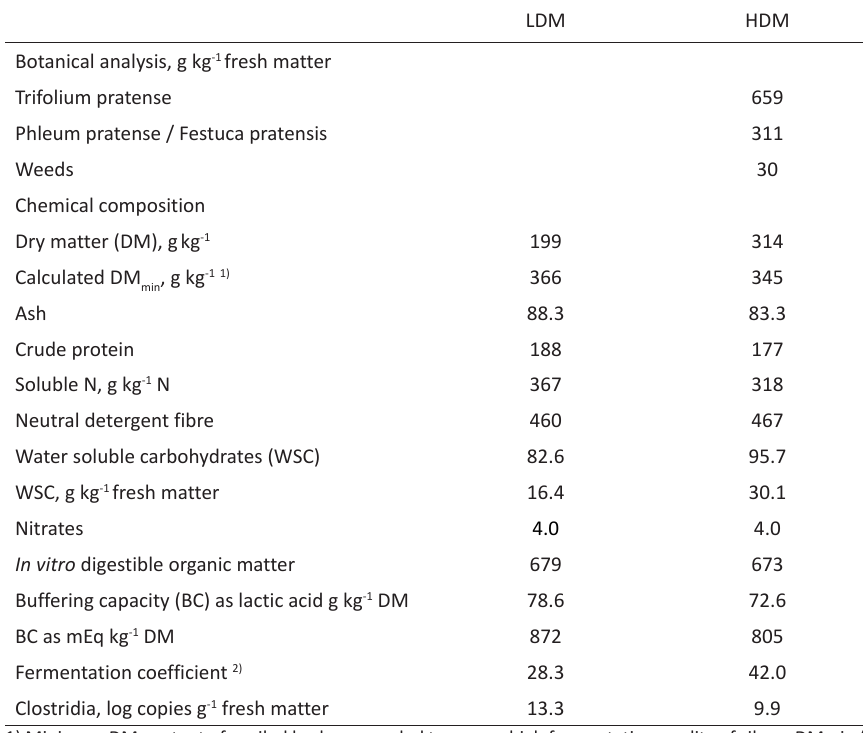
Table 2. Botanical and chemical composition and ensilability characteristics of low dry matter (LDM) and high dry matter (HDM) red clover-grass herbage (g kg -1 dry matter, unless otherwise stated) LDM